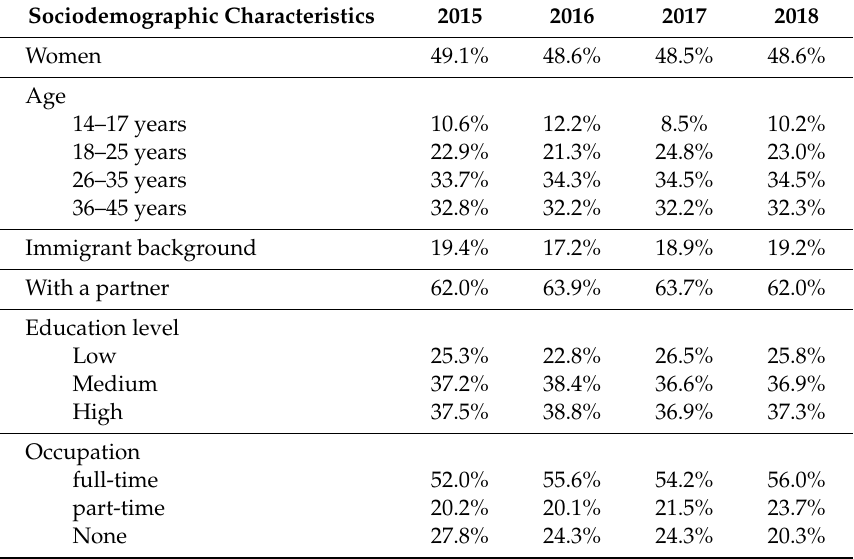
Table 1. Sociodemographic characteristics of study participants in waves 2015 to